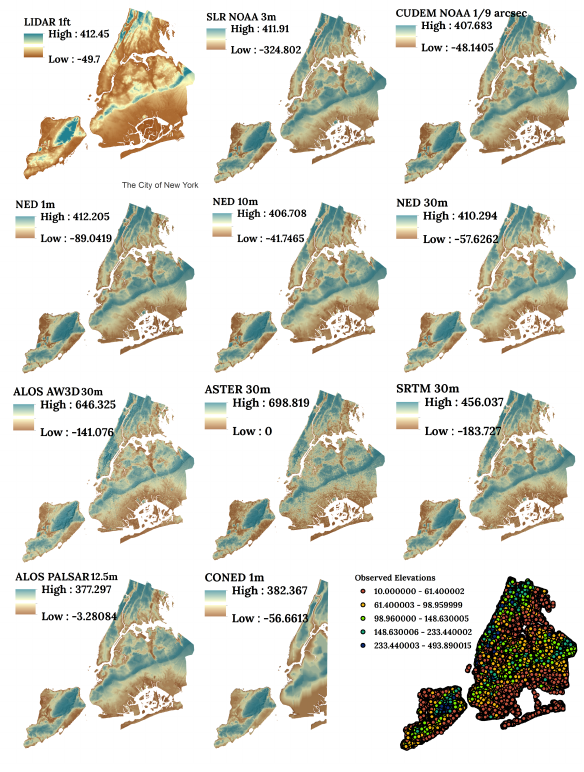
Figure 2. Shaded relief images of all DEMs at city of New York, USA (illumination from 315 o N and 20 o above horizon)